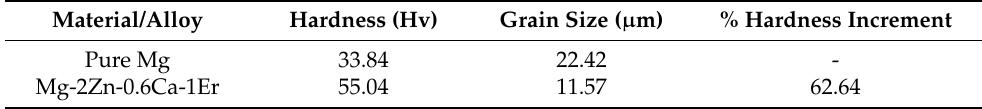
Table 1. Vickers microhardness values and grain size of Mg and its alloys .